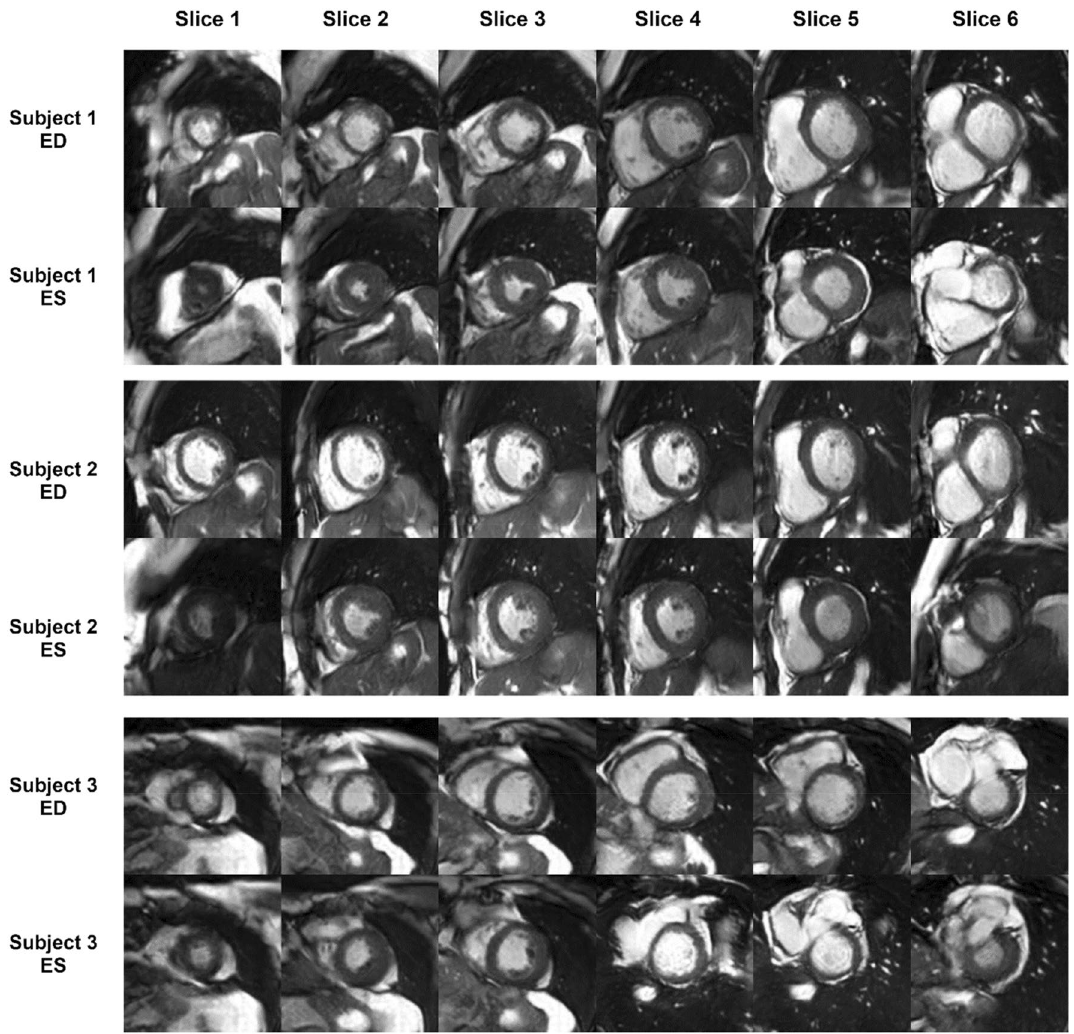
Figure 3. Examples of three synthetically generated SAX stacks at ED and